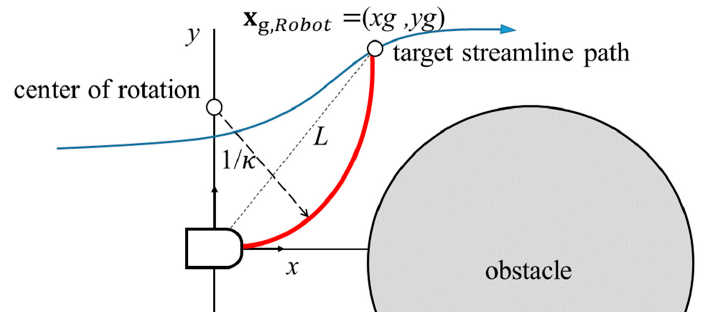
Figure 11. The flowchart of the online obstacle avoidance system for a curvature constrained non- holonomic mobile robot based on the primitive streamline paths, a path selection strategy, and a pure pursuit algorithm for streamline changing.